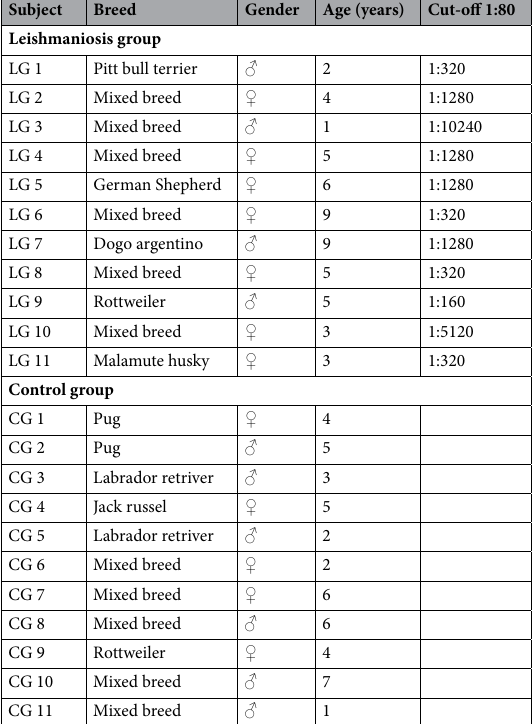
Table 1. Anamnesis of the twenty-two dogs enrolled in the